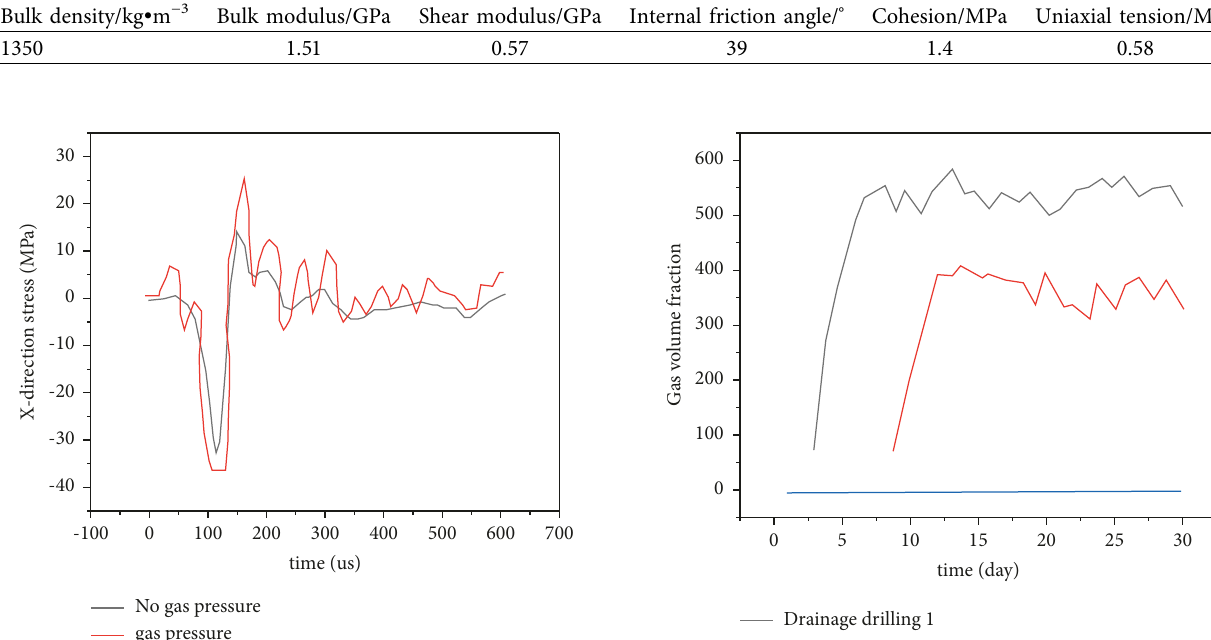
Table 2: Mechanical parameters of the model.